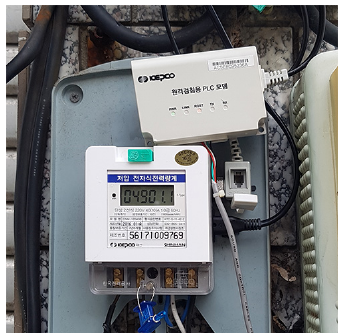
Figure 3. High-speed power line communication (HS PLC) modem connected to a smart meter (CNU Global Co.